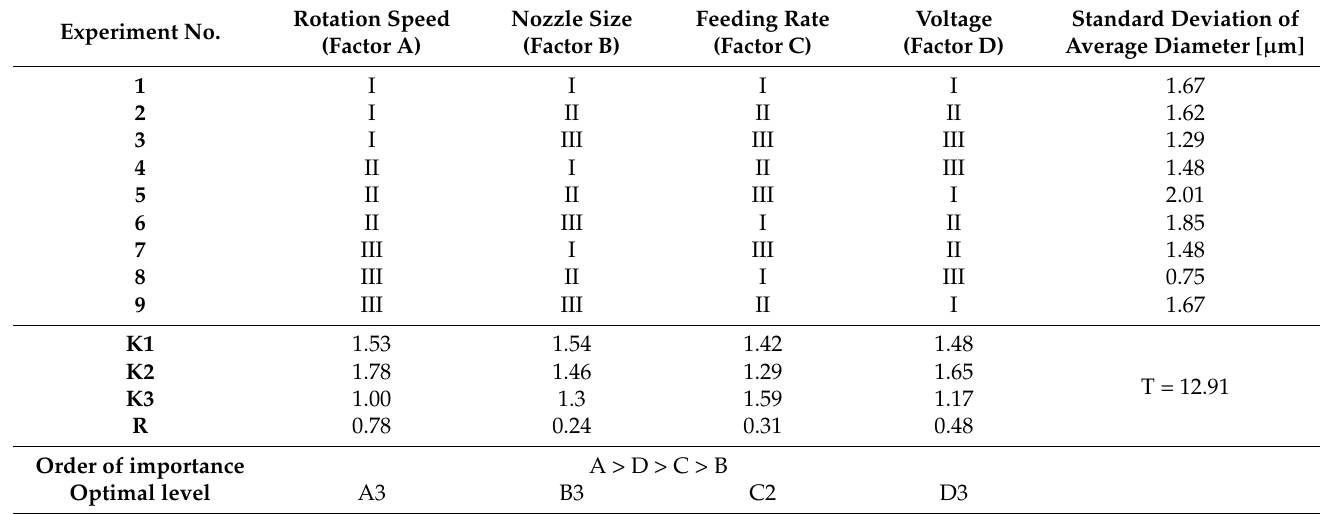
Table 4. Orthogonal test analysis on the diameter standard deviation of ECS